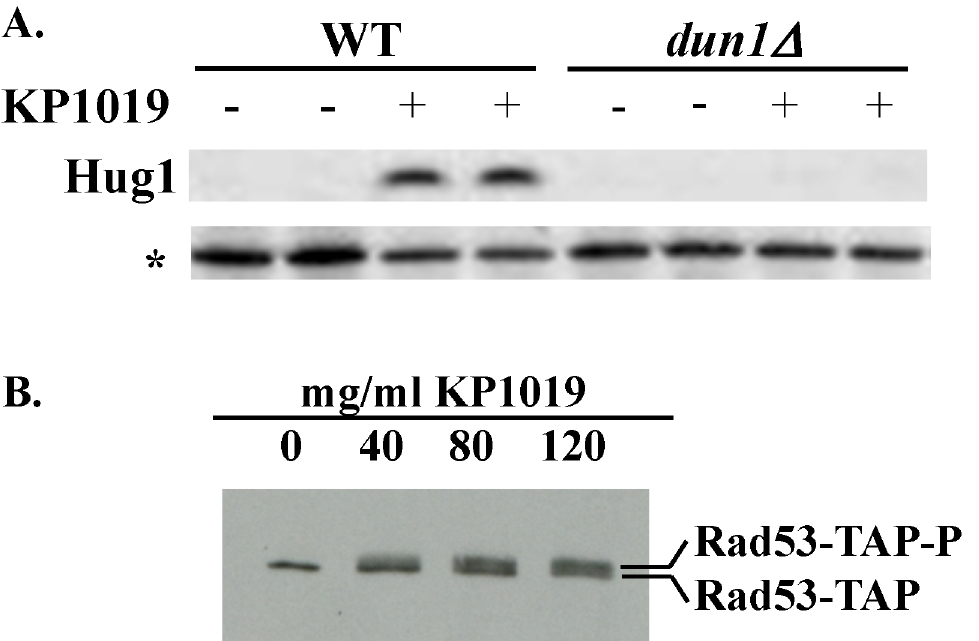
Fig 2. KP1019 induced DUN1-dependent expression of Hug1 protein and phosphorylation of Rad53. A. Early log phase wild-type (WT) and dun1 deletion (dun1 Δ ) strains were treated with 80ug/ml KP1019 for three hours (+) or untreated (-) and assayed for Hug1 protein expression. Western blot analysis was carried out as described in Materials and Methods. Each sample was run in duplicate lanes and “ * ” indicates a non-specific band that serves as the loading control. B. WT cells were incubated with increasing concentrations of KP1019 for one hour and assayed for Rad53 protein phosphorylation. Western blots were carried out as described in Materials and Methods. The shift in position of Rad53 protein consistent with increased phosphorylation is indicated by Rad53-TAP-P, while unmodified Rad53 is indicated by